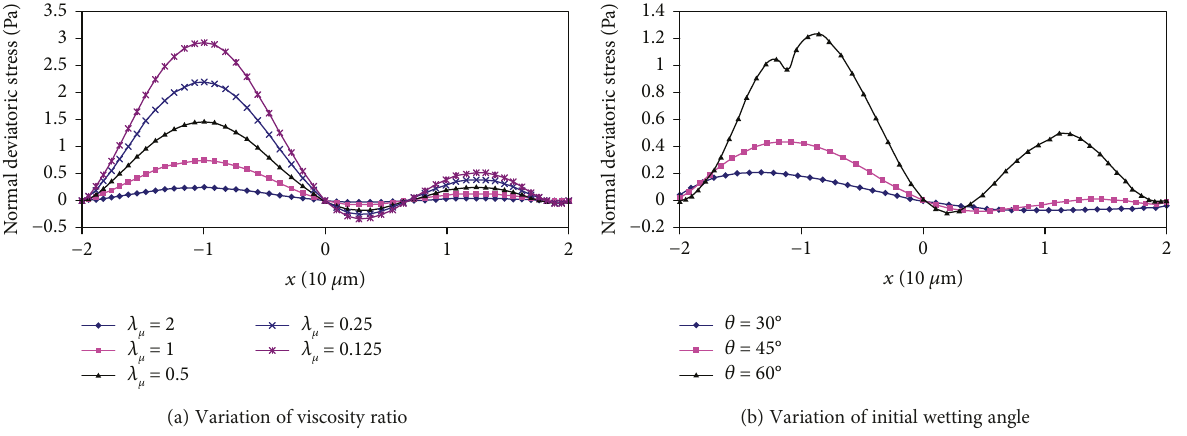
Figure 7: Curves of normal deviatoric stress variation.